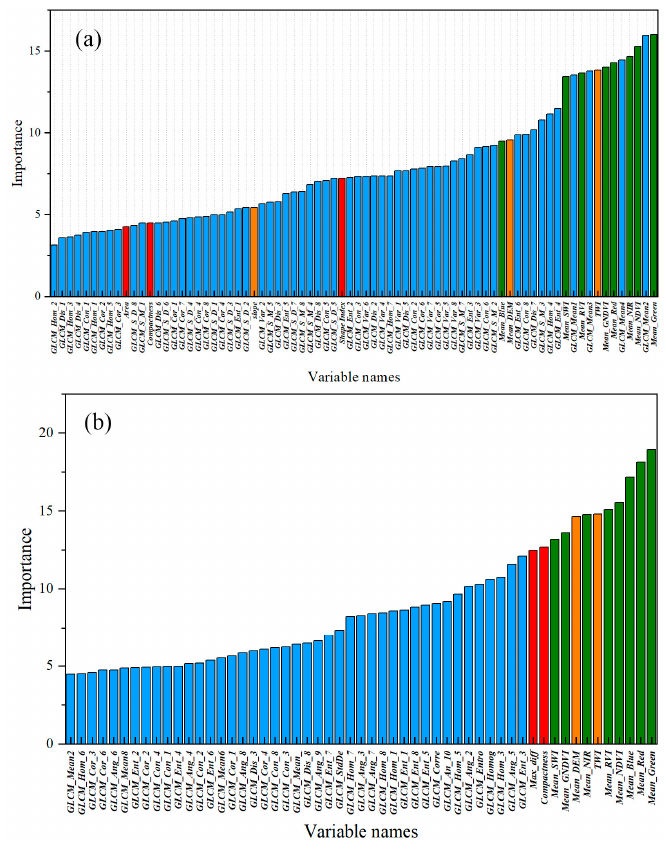
Figure 7. Change of overall accuracy with increasing number of input variables in Boruta-based variable selection (vertical red line corresponds to number of variables and overall accuracy after variable selection). ( a ) GF-1 data, ( b ) ZY-3 data.